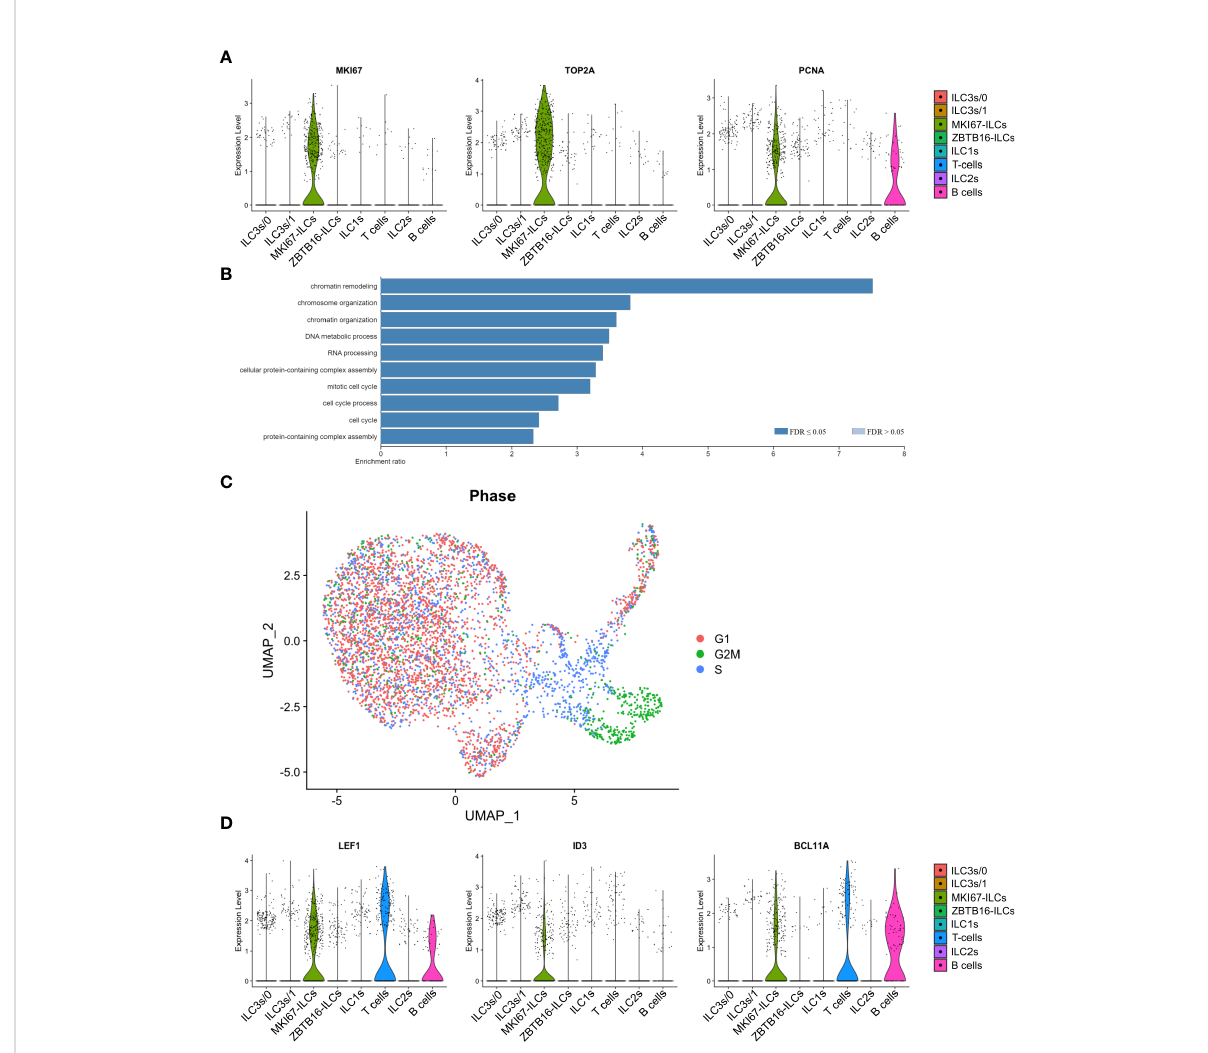
FIGURE 8 Single-cell gene signature of proliferative MKI67 -ILCs. (A) Violin plots showing expression of proliferation-associated genes in the human ILC clusters from the UMAP in Figure 7B. (B) Gene Ontology over-representation analysis of genes differentially expressed by MKI67 -ILCs. FDR, false-discovery rate. (C) Cell cycle scoring of ILCs superimposed on the UMAP from Figure 7B. (D) Violin plots showing expression of selected transcription factors in the human ILC clusters from the UMAP in Figure 7B. Data are from one single-cell RNA-sequencing experiment with spleen cells pooled from ten MISTRG mice engrafted with three pooled batches of human CD34 +